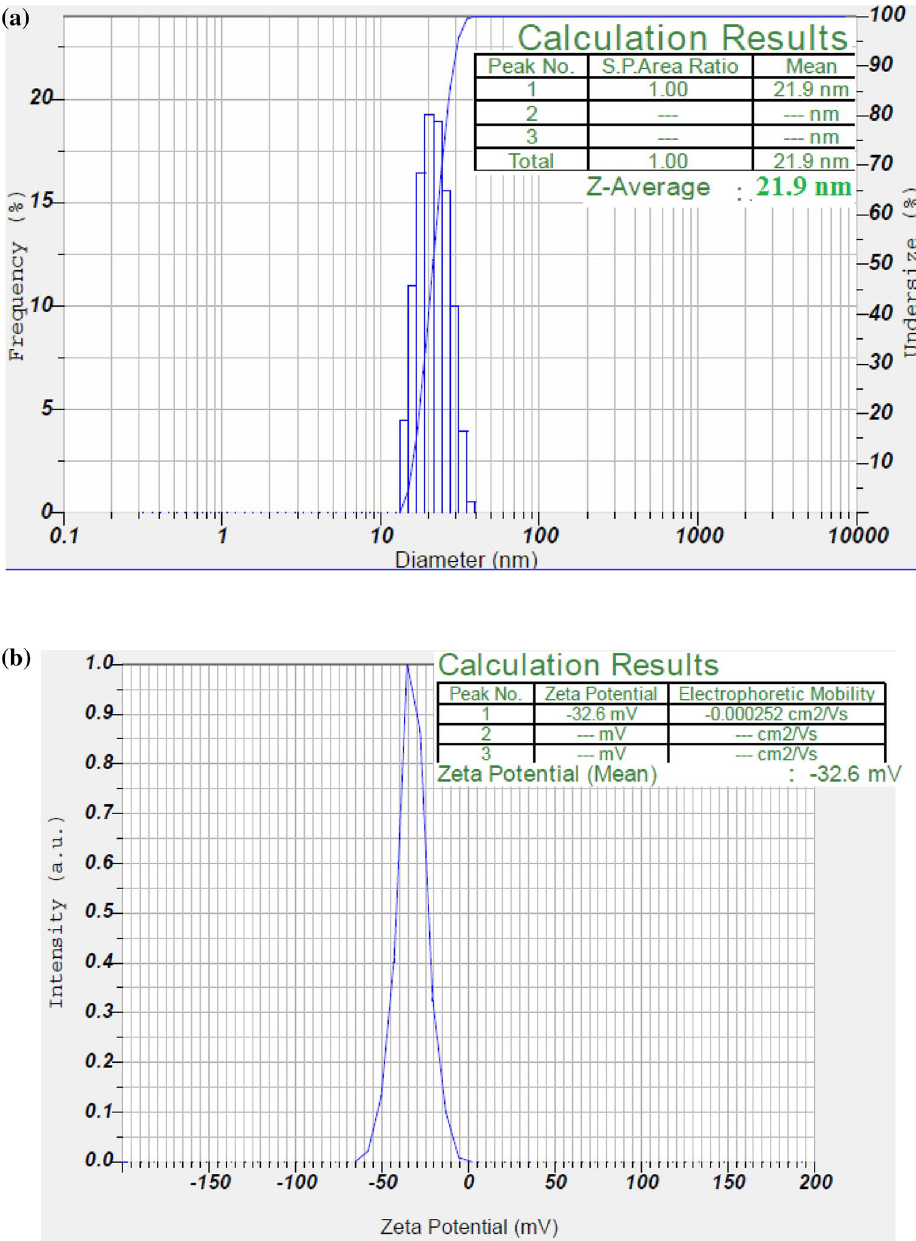
Figure 3. (a) Particle size distribution curve for Ds-AgNPs. ( b ) Zeta potential of synthesized